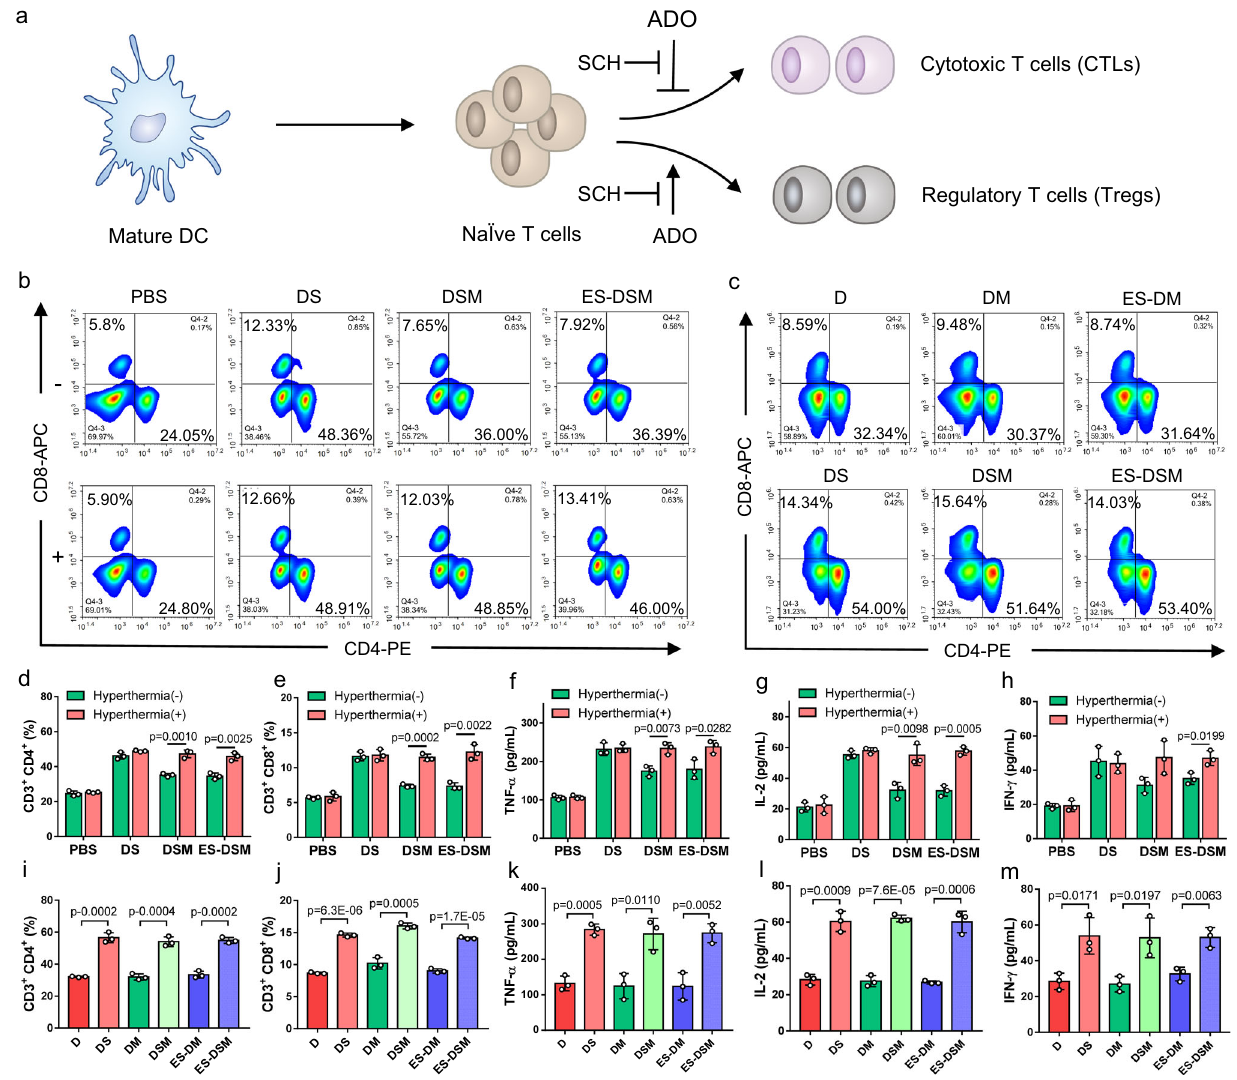
Fig. 5 Analysis of T cells after co-incubating with pretreated tumor cells and DCs. a Schematic of T-cell activation and differentiation facilitated by mature DCs. ADO can inhibit CTLs and promote Tregs by interacting with A2AR on the T-cell surface, and SCH can block this interaction and relieve immunosuppression. Flow cytometry analysis of percentages of CD3 + CD4 + and CD3 + CD8 + T cells b in the ternary co-incubation system and c in the ternary co-incubation system containing NECA. Ratios of d CD3 + CD4 + and e CD3 + CD8 + T cells calculated based on ( b ) ( n = 3 independent experiments). f TNF- α , g IL-2, and h IFN- γ secreted by lymphocytes in the co-incubation system after different treatments were detected by ELISA kits ( n = 3 independent experiments). Ratios of i CD3 + CD4 + and j CD3 + CD8 + T cells calculated based on c (n = 3 independent experiments). k TNF- α , l IL-2, and m IFN- γ secreted by lymphocytes in the NECA- containing co-incubation system after different treatments were detected by ELISA kits ( n = 3 independent experiments). ADO: adenosine; A2AR: A2A adenosine receptor; NECA: an analog of adenosine; DS: free DOX and SCH; DSM: DOX and SCH co-loaded micelles; ES-DSM: E-selectin-modi fi ed co-loaded micelles; D: free DOX; DM: DOX-loaded micelles; ES-DM: E-selectin-modi fi ed DOX-loaded micelles. Data are presented as mean values±SEM, and the mean value is the average of three independent experiments. Unpaired two-tailed T test was performed in ( d – m ). Source data are provided as a Source data fi